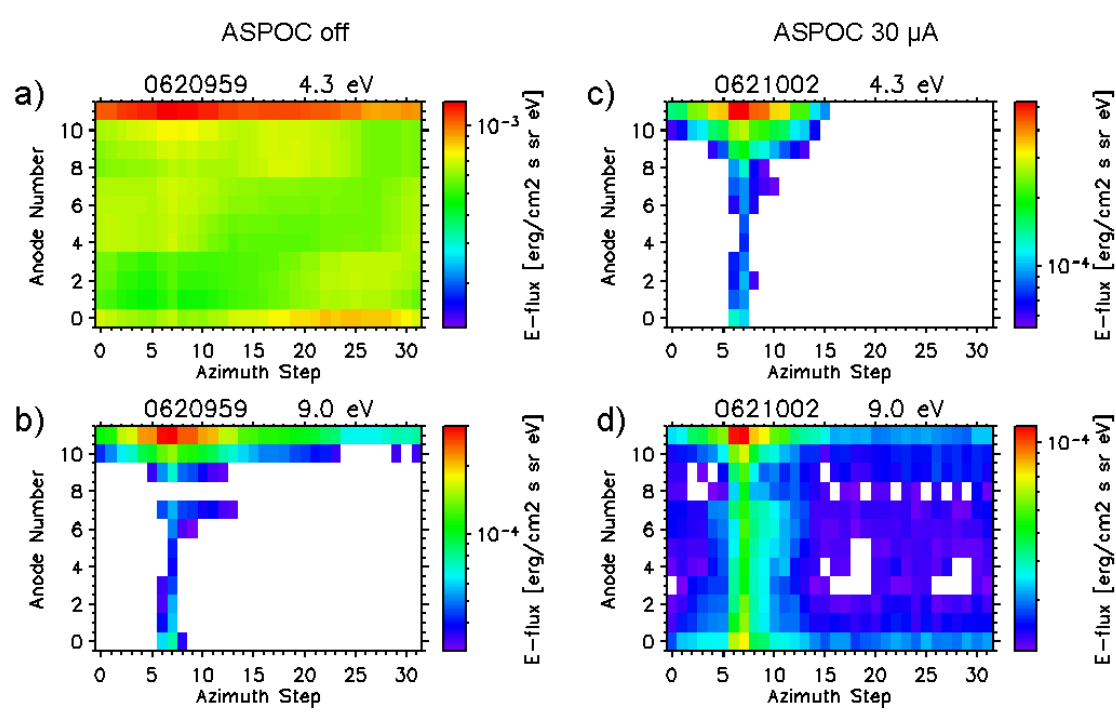
Fig. 10. Energy flux over azimuthal and polar angle at two energies, and for 0 and 30 µ A ion beam current: (a) 4.3eV, no ion beam, (b) 9.0eV, no ion beam, (c) 4.3eV, 30 µ A ion beam, (d) 9.0eV, 30 µ A ion